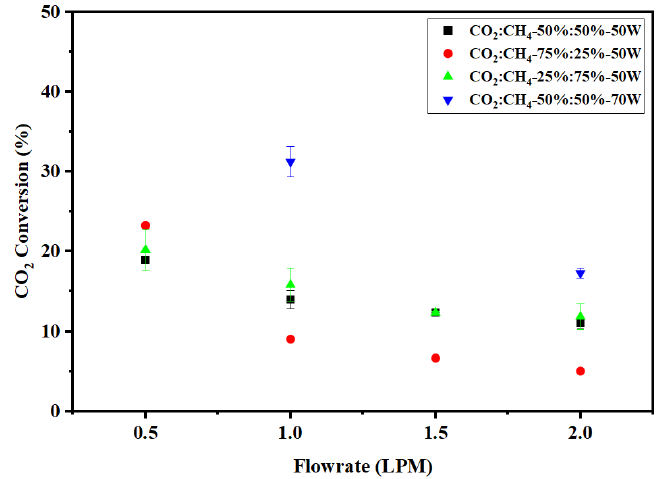
Figure 4. Effect of flow rate on CO 2 conversion.